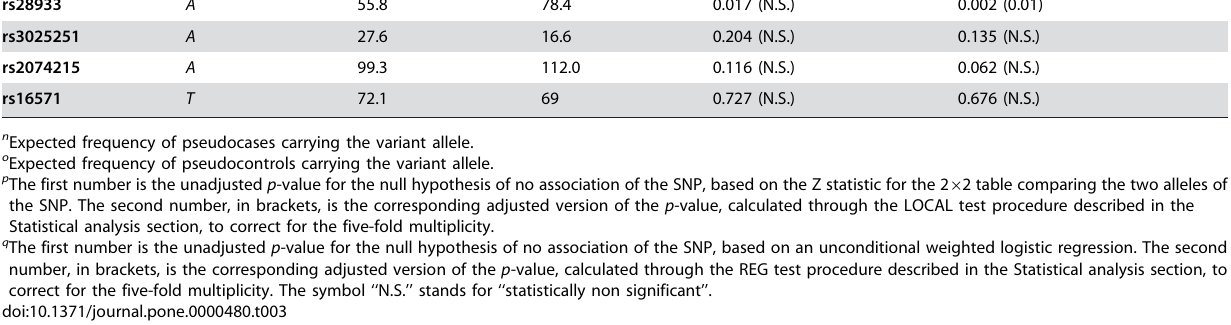
Table 3. Association testing of each of the five SNPs genotyped in the ACCN1 . .. ... .... ... ... .... ... ... .... ... ... .... ... ... .... ... ... .... ... ... .... ... ... .... ... ... .... ... ... .... ... ... .... ... ... .... ... ... .... ... ... .... ... ... .